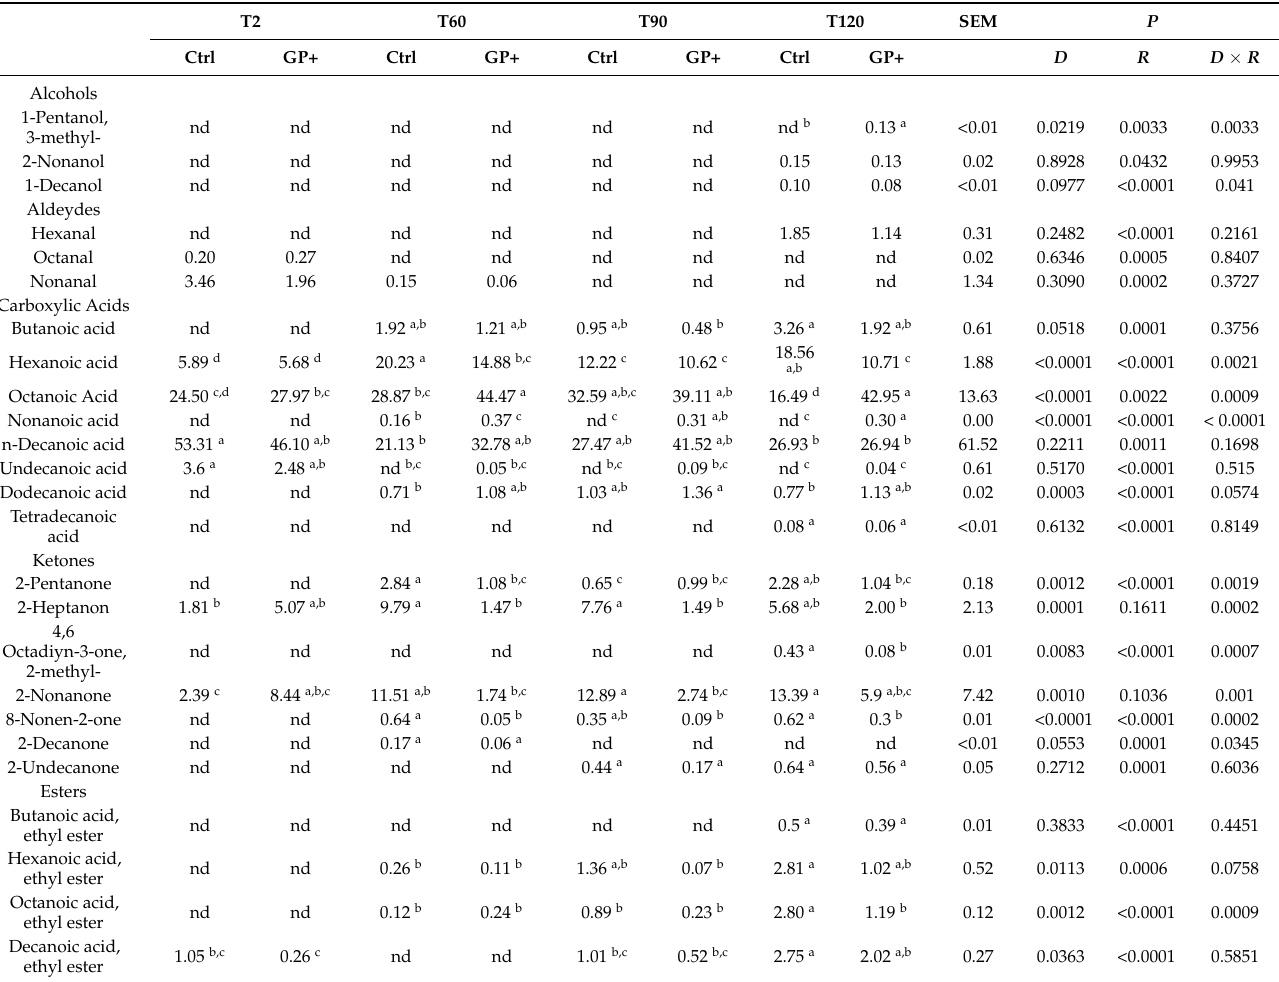
Table 1. Volatile organic compounds detected in cheese after 2 (T2), 60 (T60), 90 (T90) and 120 (T120) days of ripening, obtained from raw milk of ewes fed standard diet (Ctrl) and grape pomace diet